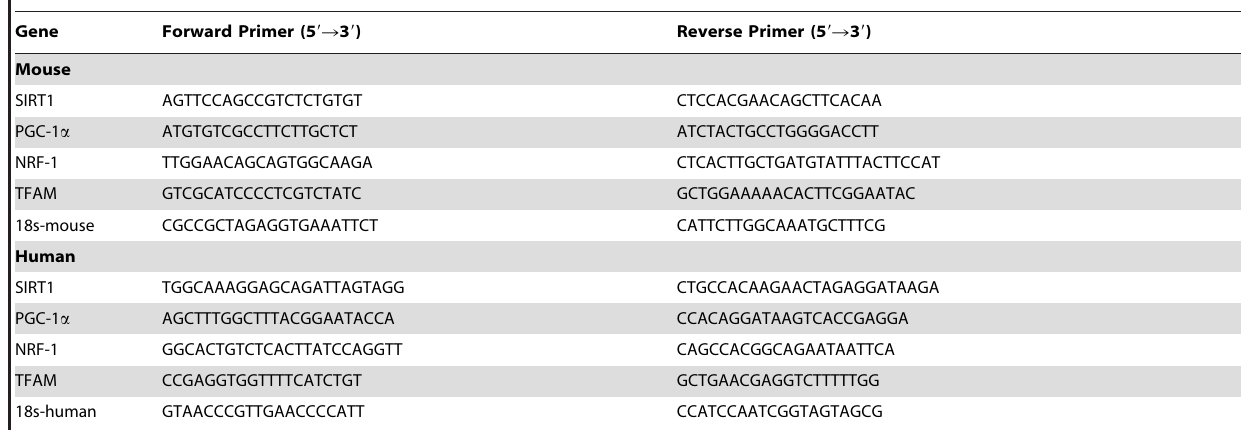
Table 1. Primers used for Real-time